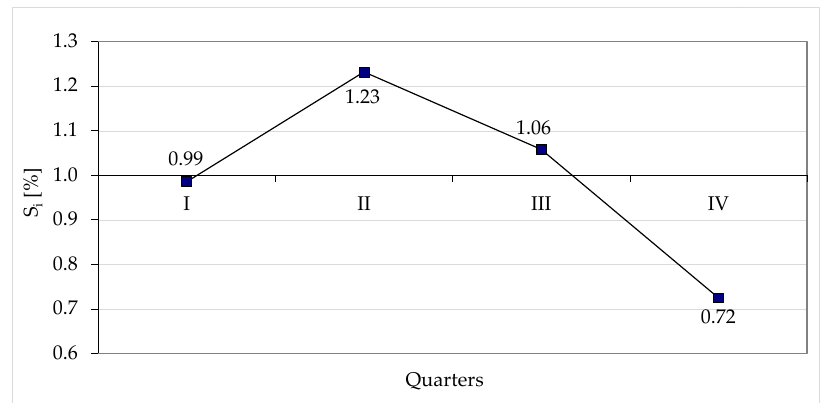
Figure 6. Relative seasonal fluctuations in number of failures in the water network. Energies 2020 , 13 , x FOR PEER REVIEW